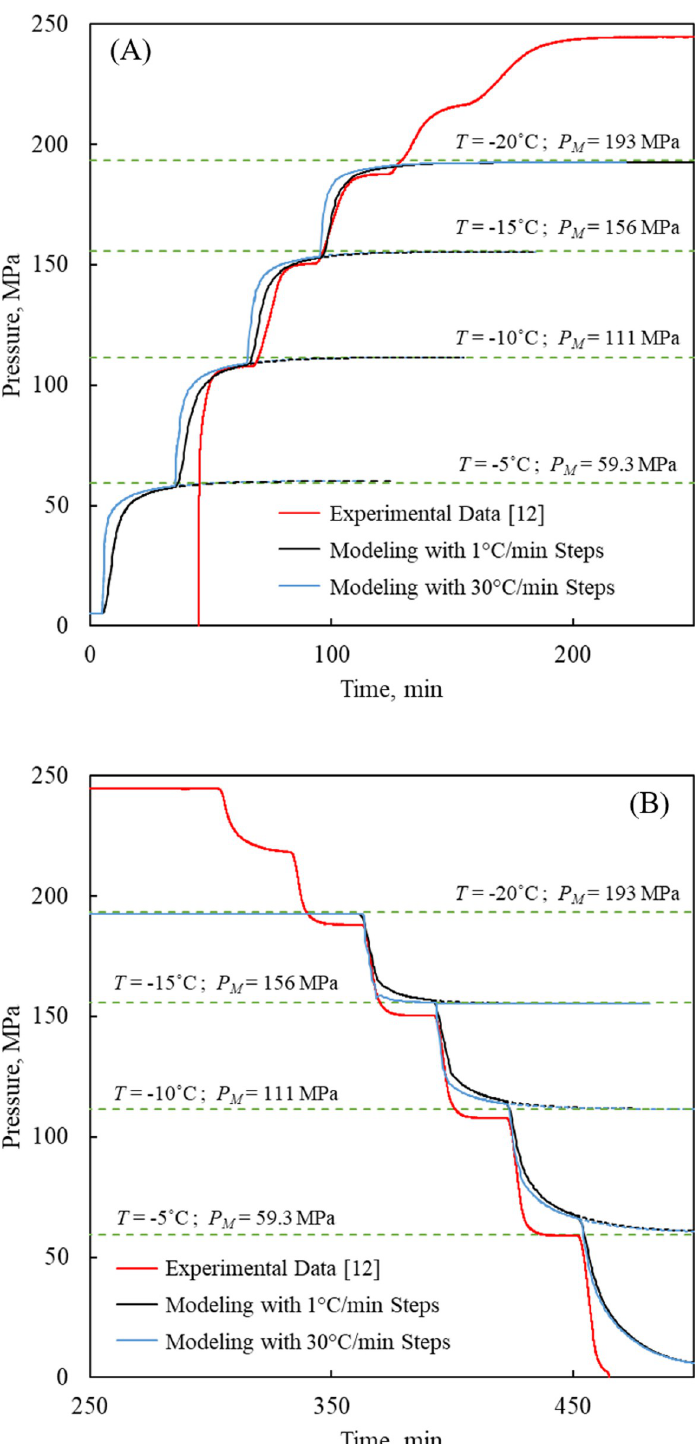
Fig 6. Temperature-pressure histories in the isochoric chamber illustrated in Fig 2A subject to various temperature rates. Temperature-pressure histories subject to (A) stepwise cooling of the isochoric chamber; and (B) stepwise